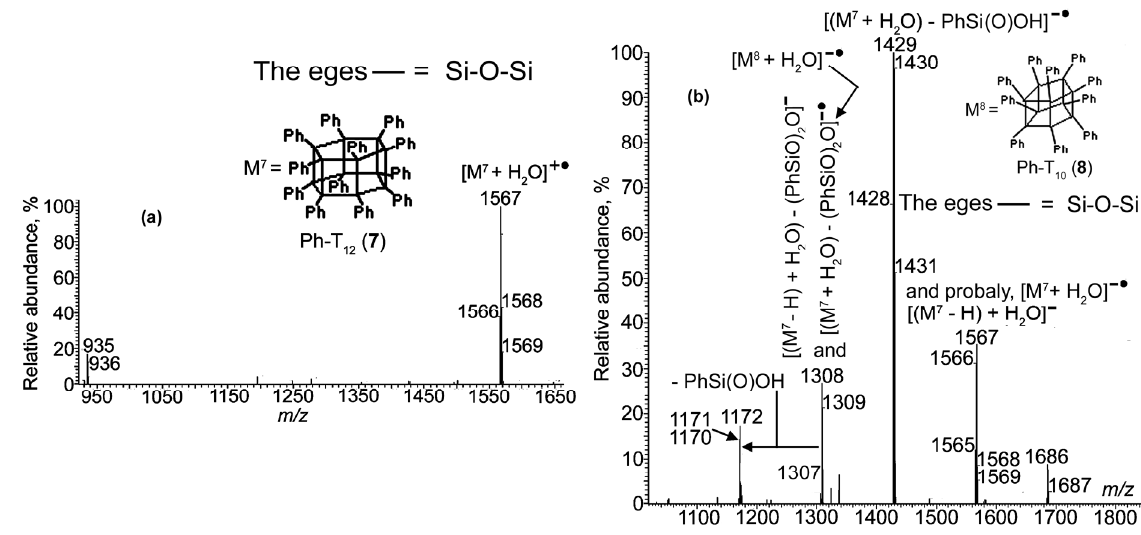
Figure 6. APCI mass spectra of compound 7 recorded in ( a ) the PI mode and ( b ) in the NI mode.